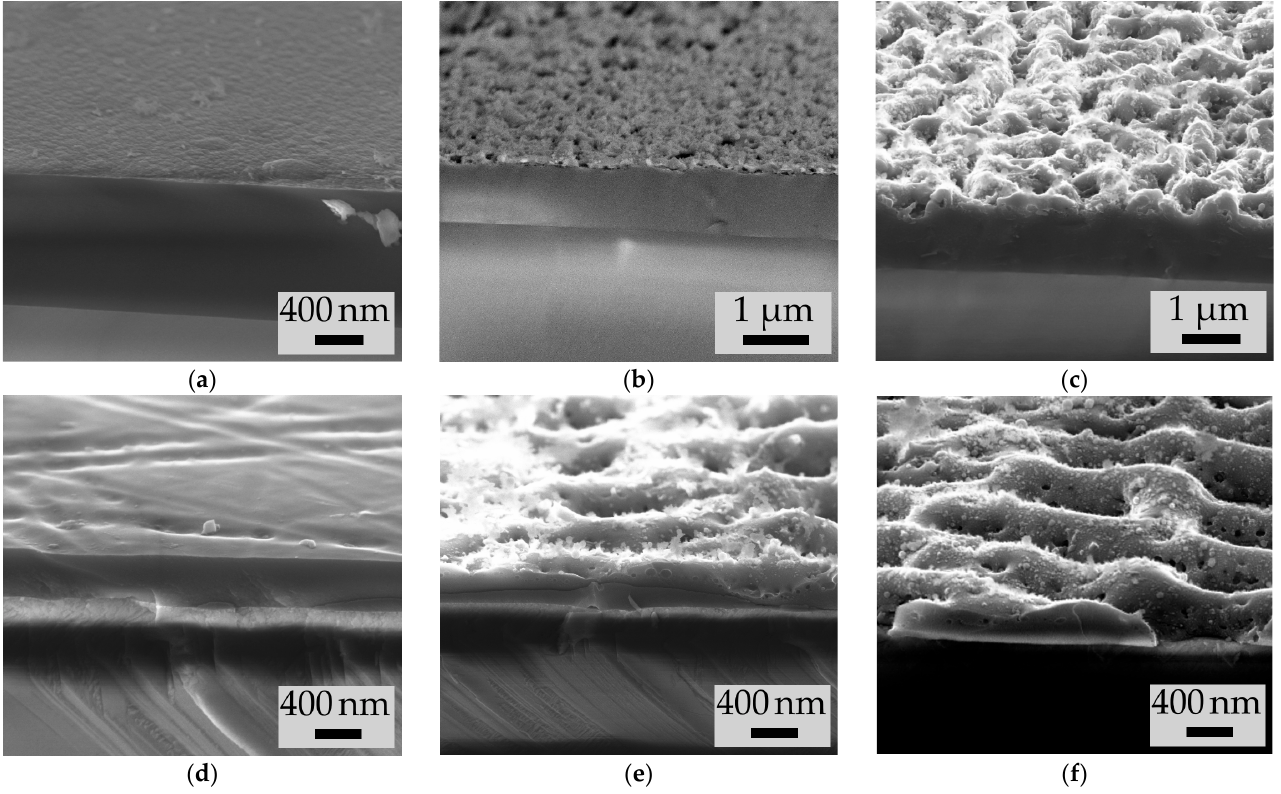
Figure 5. SEM images of the cross sections of the samples ( a ) unirradiated p-a-Si ( b ) P1, ( c ) P2, ( d ) unirradiated n-a-Si ( e ) N1 and ( f ) N2, obtained at a 10° angle to the cross section surface. ( d ) unirradiated n-a-Si ( e ) N1 and ( f ) N2, obtained at a 10 ◦ angle to the cross section